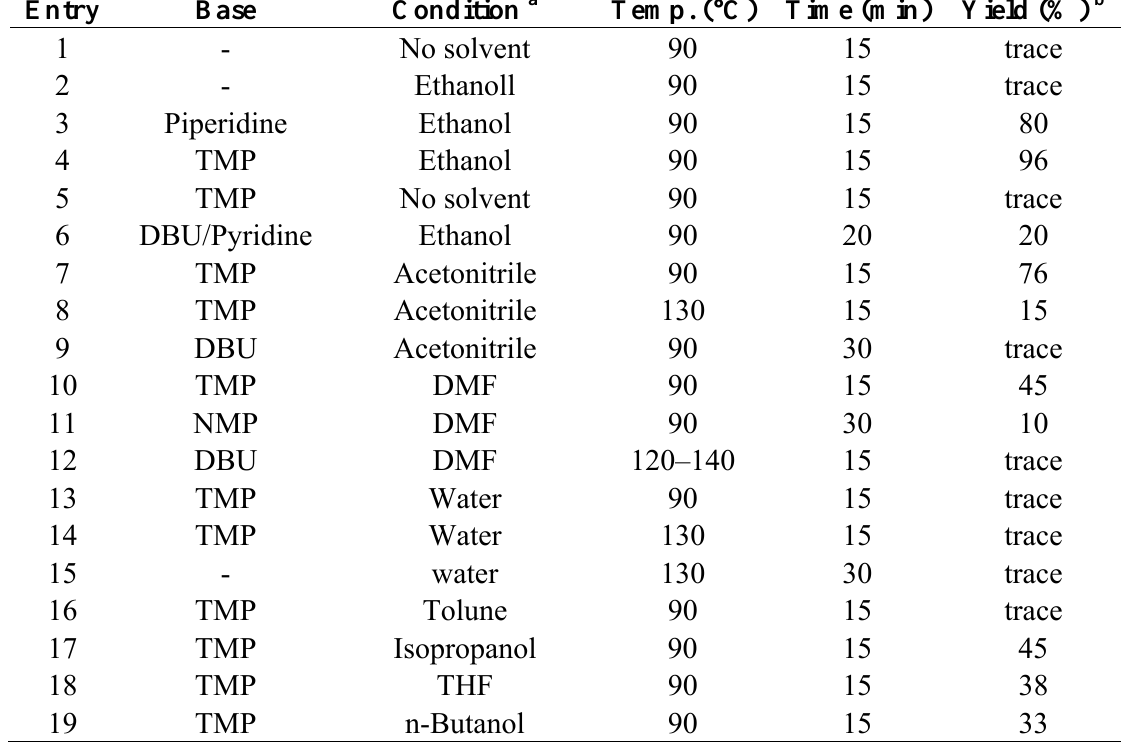
Table 1. Screening of solvents, reaction time and temperature for the synthesis of 2a .